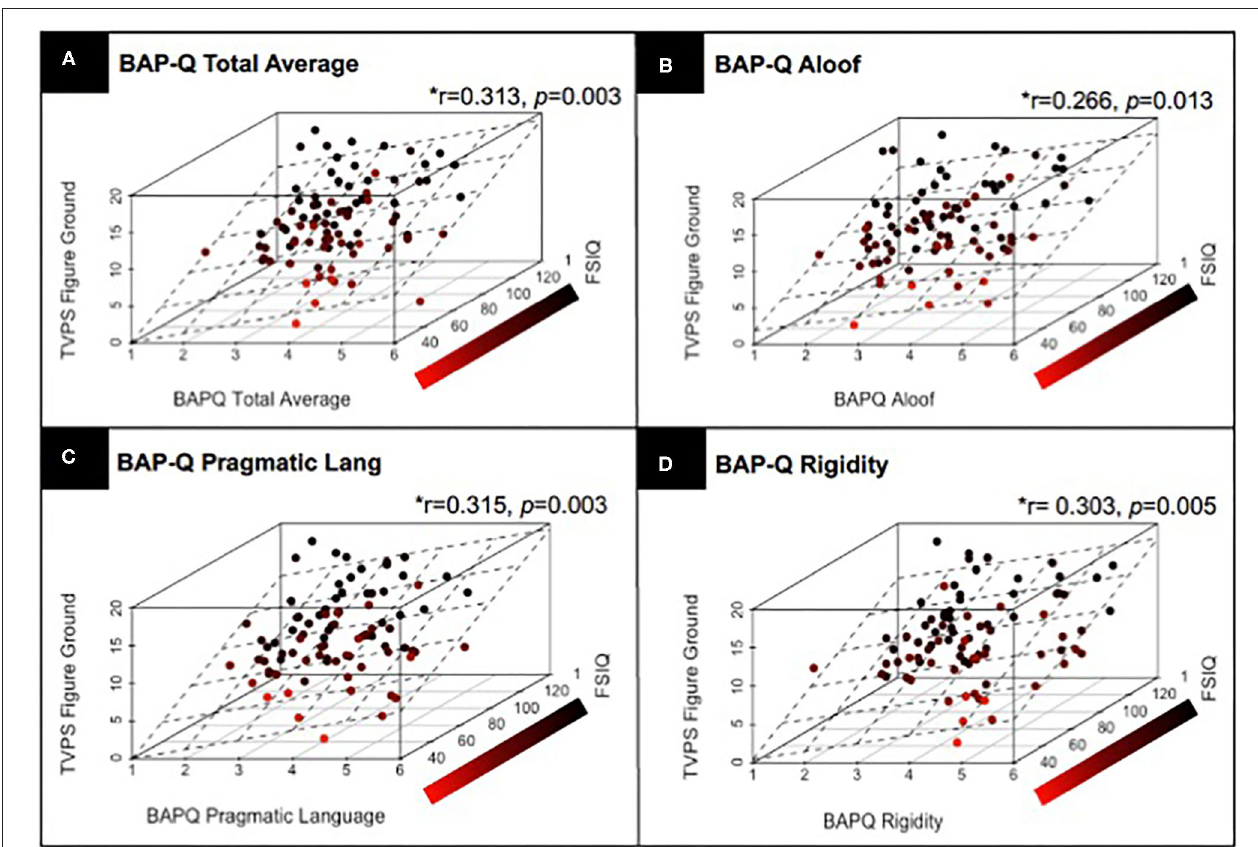
FIGURE 3 | Results from a partial correlation (FSIQ) with correction for multiple comparisons, across children with and without ASD, demonstrating the relationship between TVPS-FG subtest scores and (A) BAP-Q Total scores; (B) BAP-Q Aloof subscales scores; (C) BAP-Q Pragmatic Language Scores; and (D) BAP-Q Rigidity subscale scores. Linear planes represent the results of a linear regression using FSIQ and (A) BAP-Q Total scores as well as (B–D) BAP-Q Aloof, Pragmatic Language, and Rigidity subscale scores to predict TVPS-FG subtest scores across children with and without